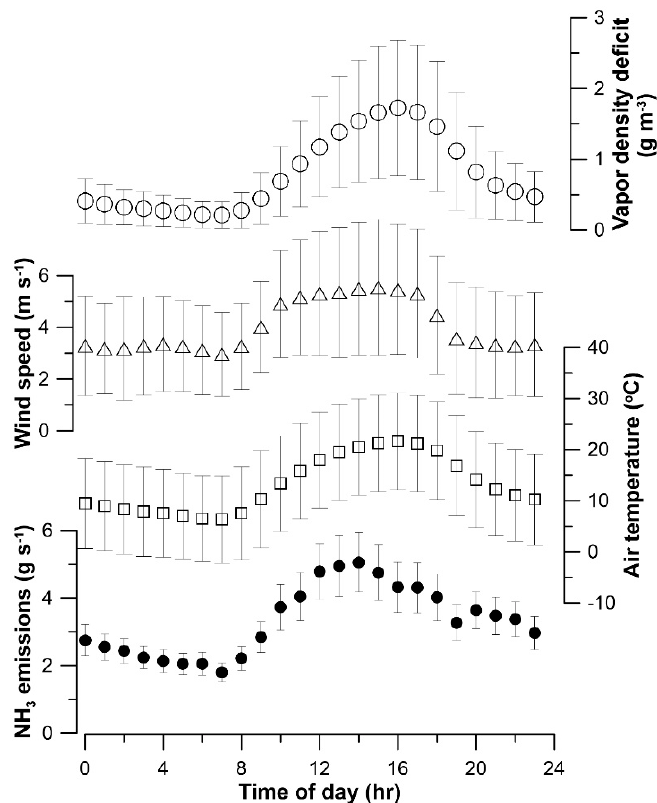
Figure 5. Diurnal variation in emissions and related variables. The mean hourly air temperature (open square) and wind speed (open triangle) and water vapor density saturation deficit (open circle) is compared against the mean hourly NH 3 emissions with TD = 0.4 (solid circles). Bars represent one standard deviation of the hourly measured emissions.